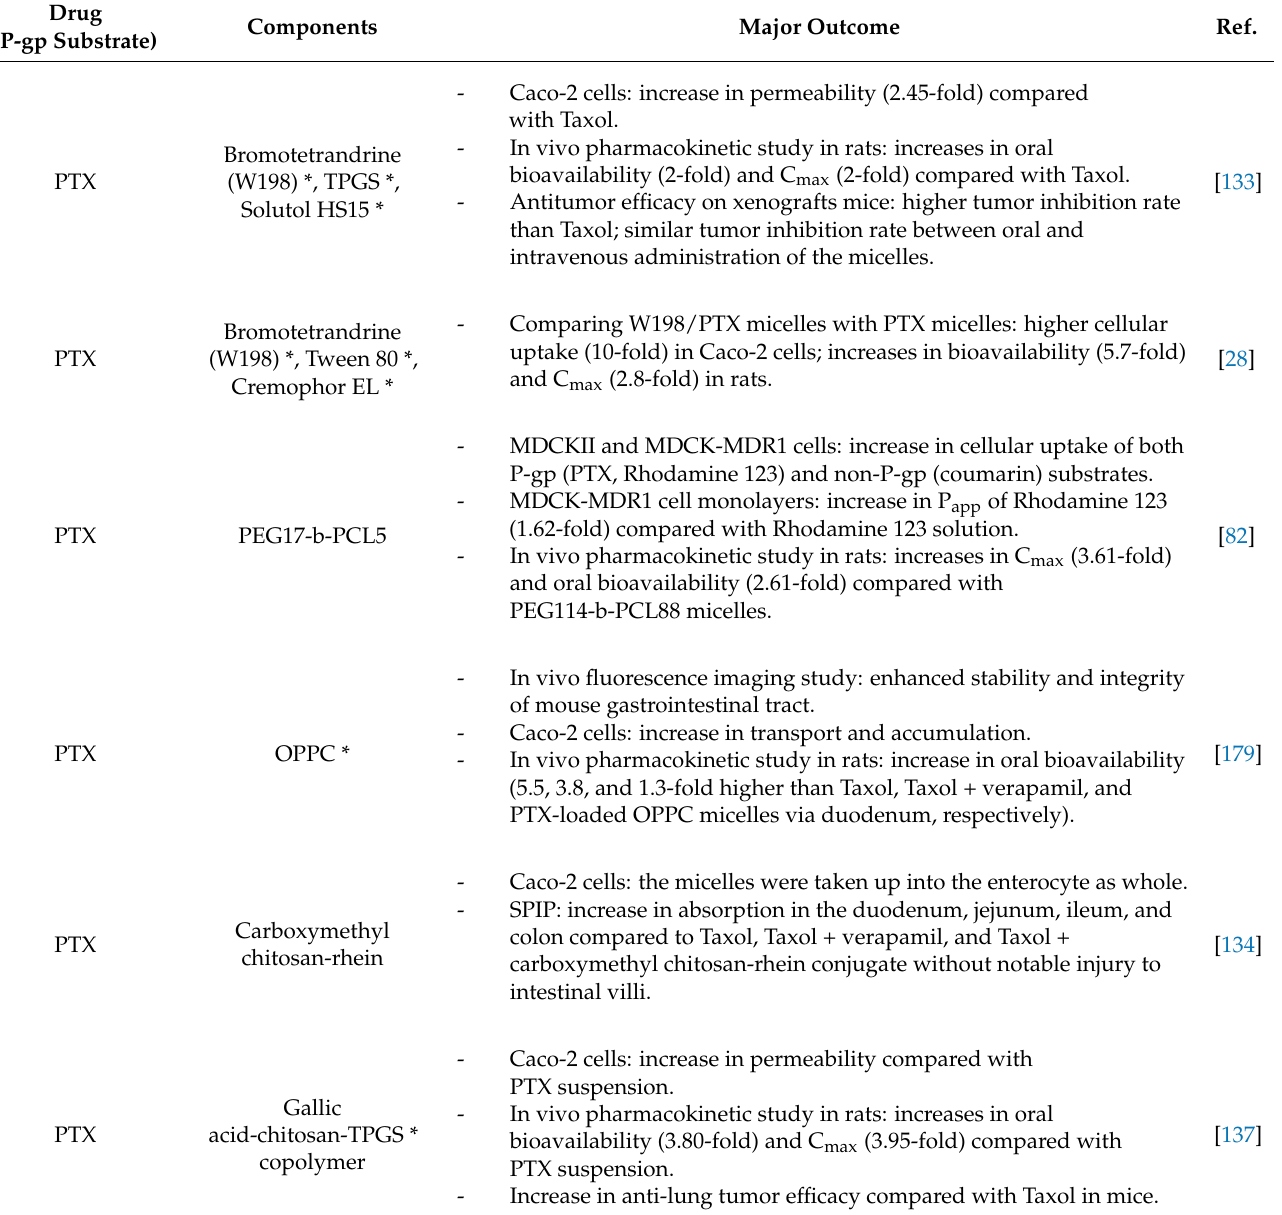
Table 4. Micelles with P-gp inhibitory